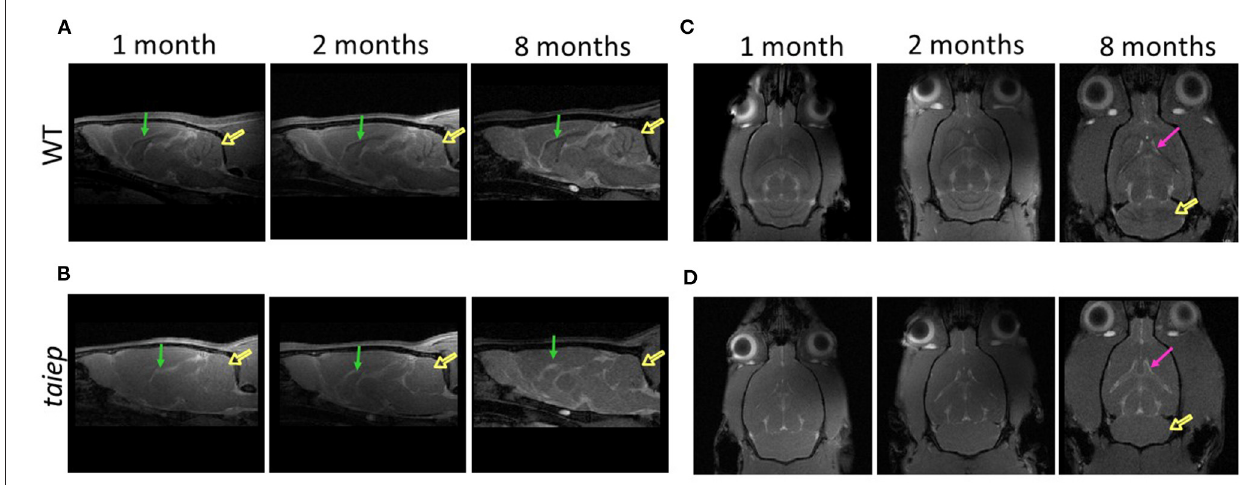
FIGURE 4 | Comparative analysis of the development of brain structures in the taiep rat. Representative images of sagittal T2-weighted MRIs obtained at 1, 2, and 8 months for the wild-type and taiep rat (A,B) . Signals of the white matter of cerebellum (open arrows) and corpus callosum (arrows) are less visible in taiep rats compared to WT. Representative axial T2-weighted MRIs obtained at 1, 2, and 8 months (C,D) . Progressive enlargement of lateral ventricles (arrows) and cerebellar demyelination (open arrow) is observed in taiep rat at 8 months (C,D) .